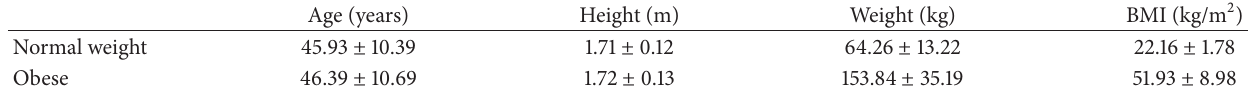
Table 1: Table of anthropometric measures (mean ± standard deviation) for age, height, weight, and BMI of participants divided by group.